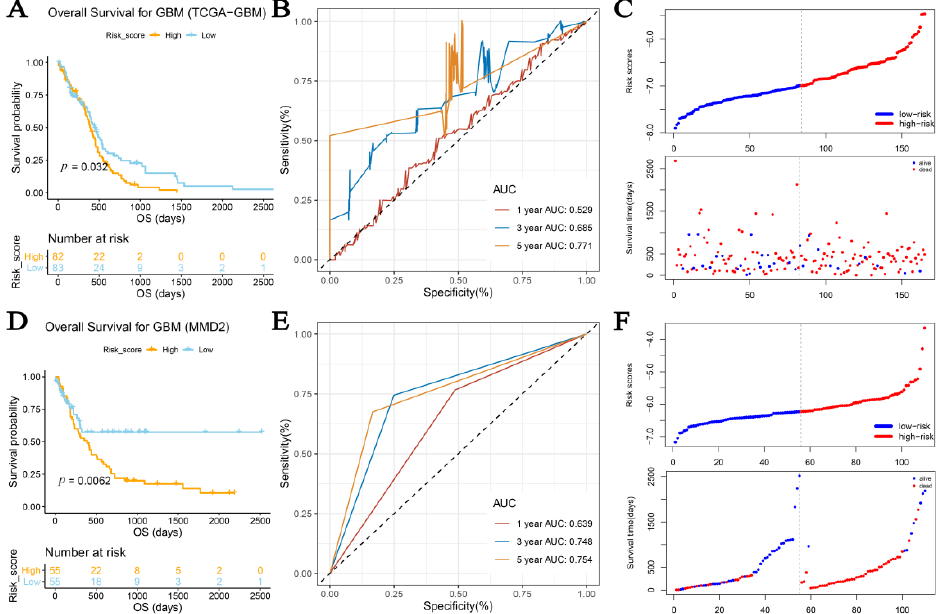
Figure 9. Cox regression analysis and construction of new immune-related prognostic signature. ( A ) Based on TCGA-GBM data, graphs show Kaplan–Meier OS curves for high- and low-risk groups. ( B ) ROC curve shows accuracy of immune-related prognostic signature for OS. ( C ) Distribution of